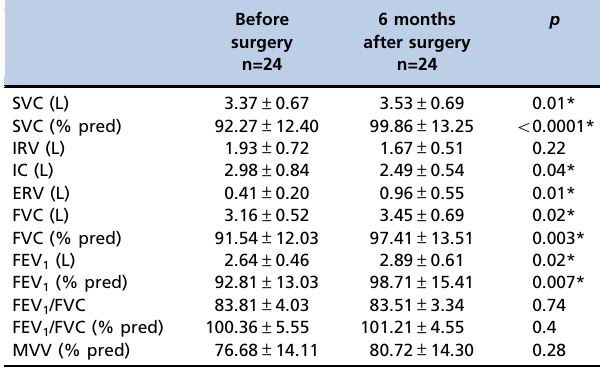
Table 2 - Spirometric variables before and after bariatric surgery. Before